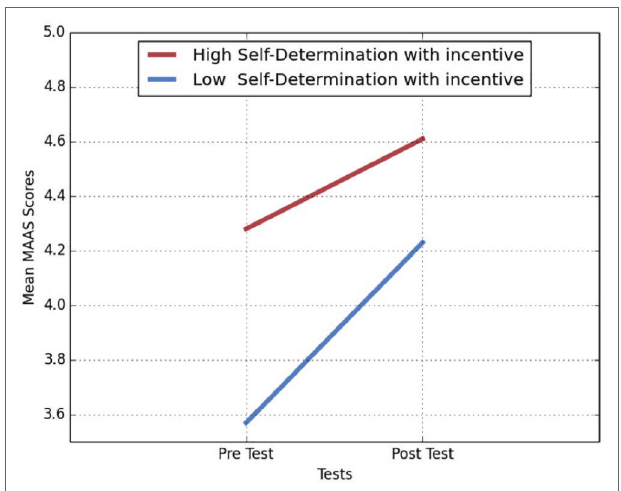
FIGURE 2 | Mean MAAS scores of group